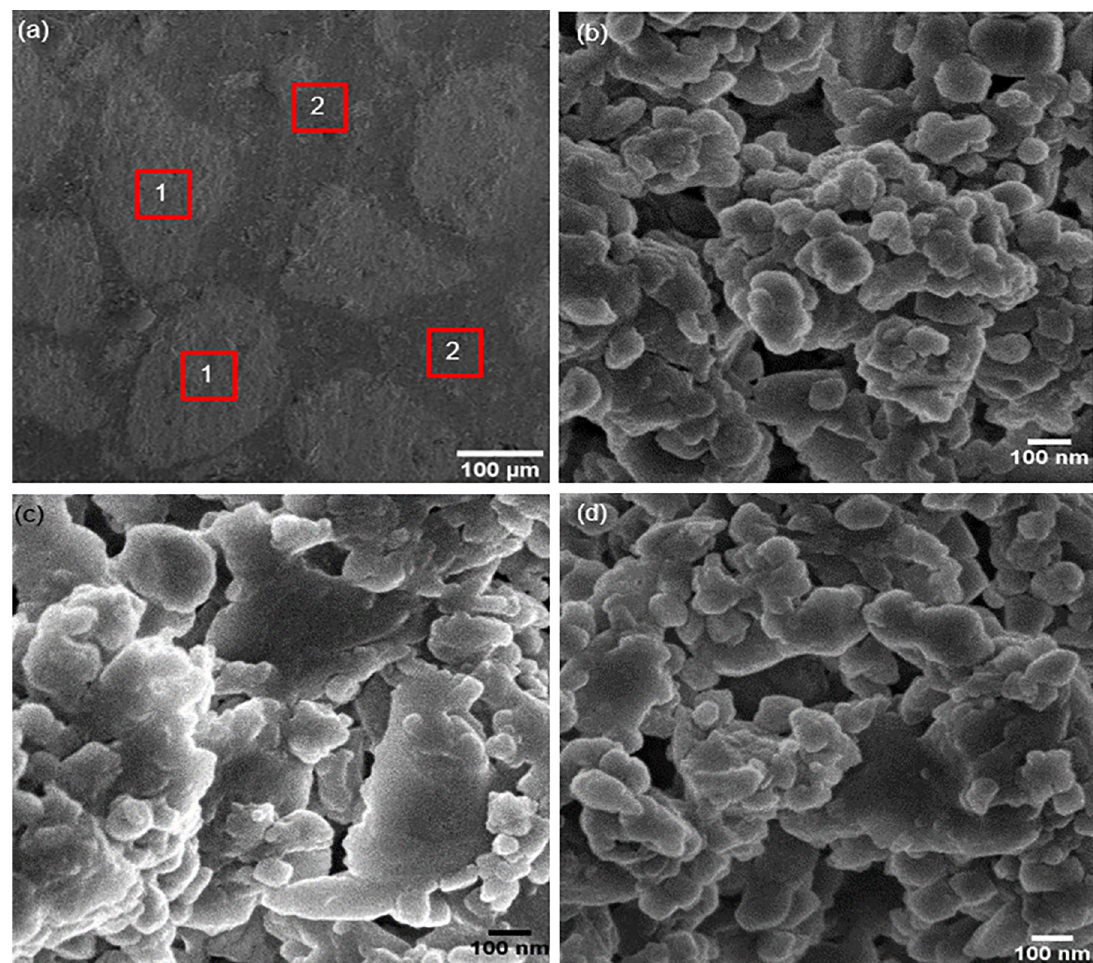
Figure 7. a) SEM image of Sikadur 30 cross-section surface before tensile test. (b) Predominated granular phase, magnified image of region 1 (c) Predominated continuous phase, magnified image of region 2 (d) Interfacial phase between region 1 and region